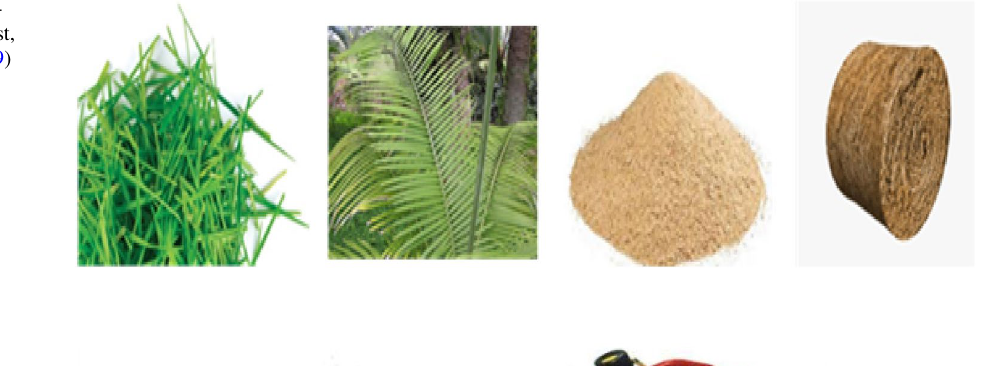
Fig. 3 Examples of